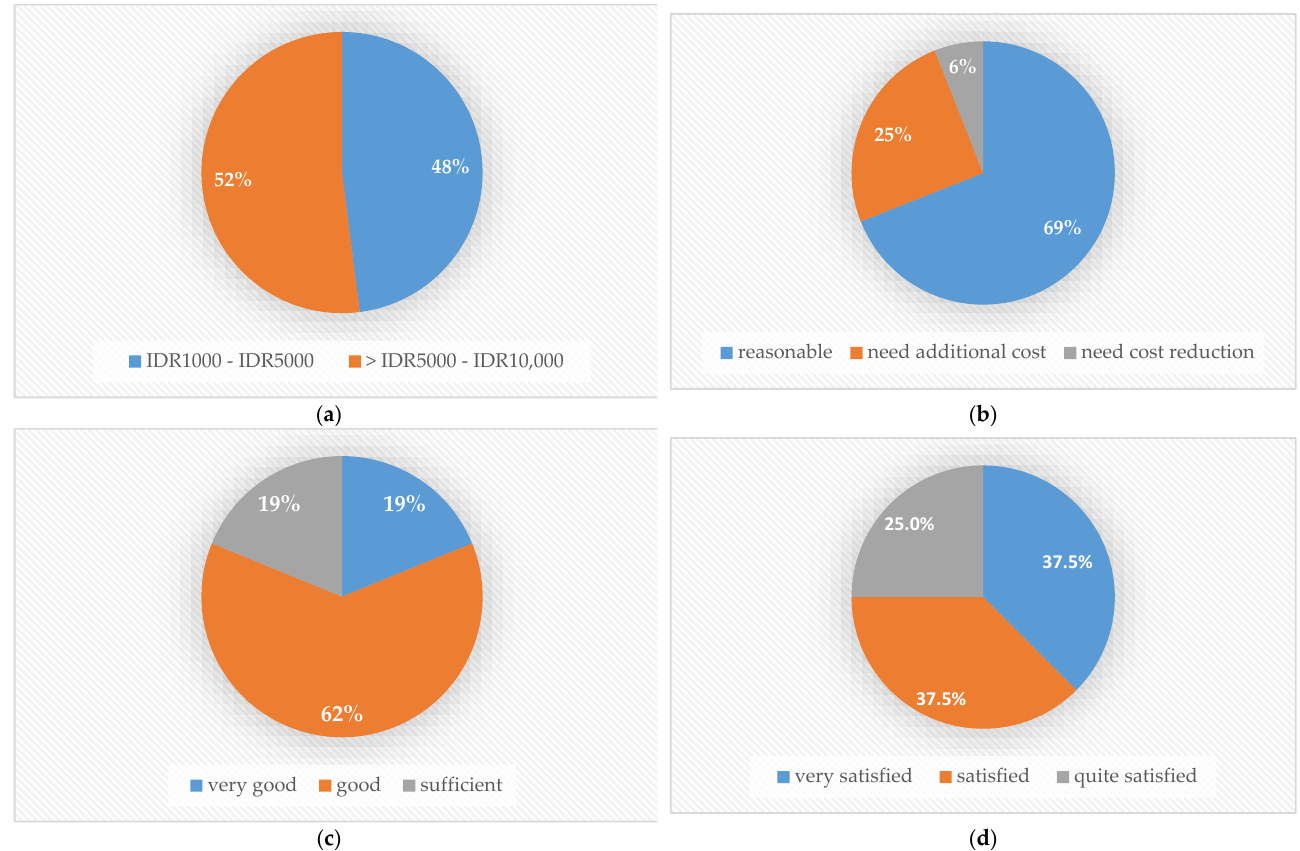
Figure 4. Survey of CWWTP users in the Mlati sub-district regarding ( a ) monthly fee payment amounts, ( b ) perception of subscription cost, ( c ) perception of the CWWTP operational performance, and ( d ) the perception of CWWTP service.